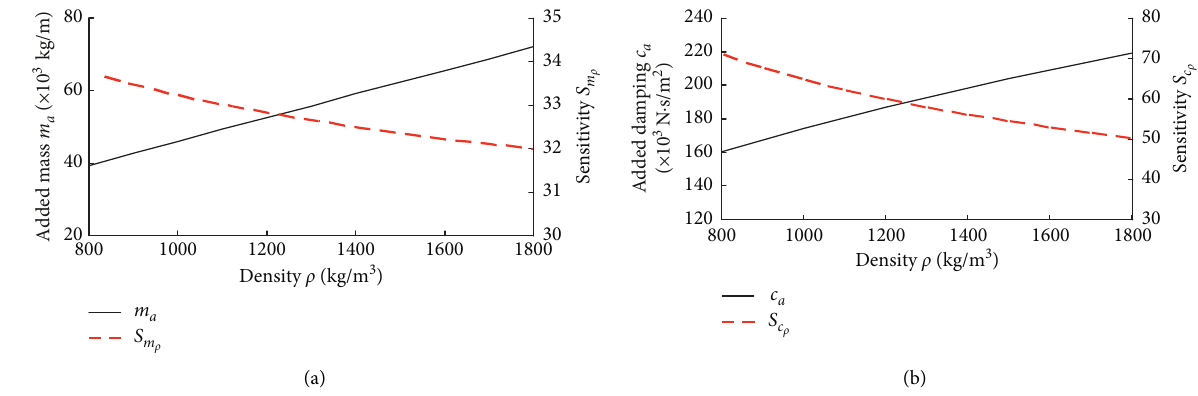
Figure 2: Influence of density on the added mass (a) and added damping